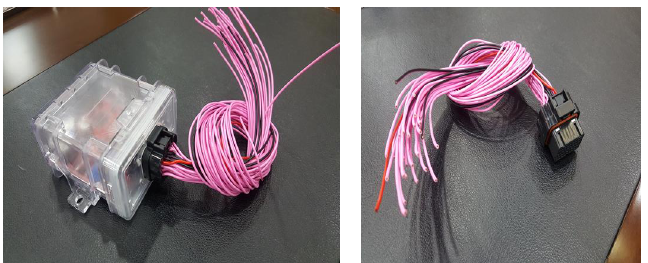
Figure 5. Mechanism of electronic control approach. Sensors 2019 , 17 , x FOR PEER